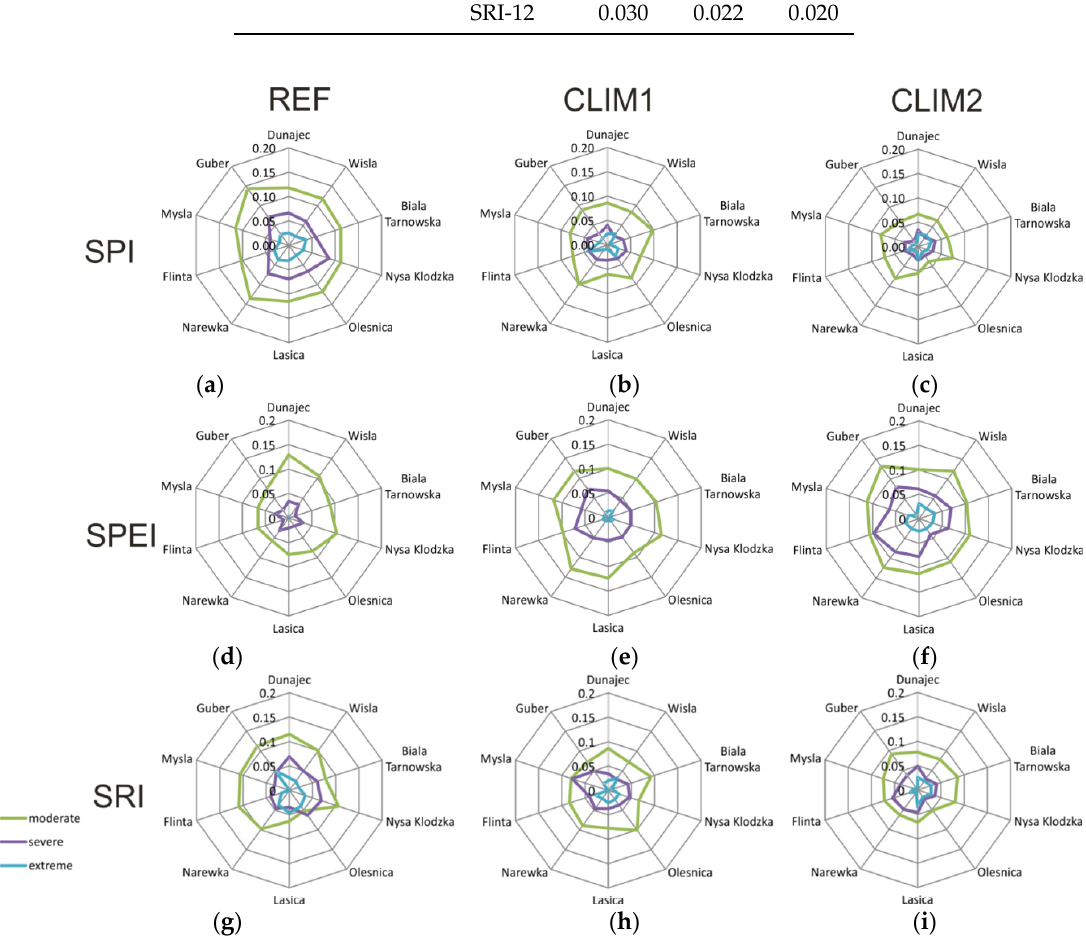
Figure 7. A comparison of the probability of drought ocurrence calculated using SPI-12 ( a – c ), SPEI-12 ( d – f ) and SRI-12 ( g – i ), in ten Polish catchments, in three periods: ref (1971–2000)— a , c , g ; clim1 (2021–2050)— b , e , h ; and clim2 (2071–2100)— c , f , i .